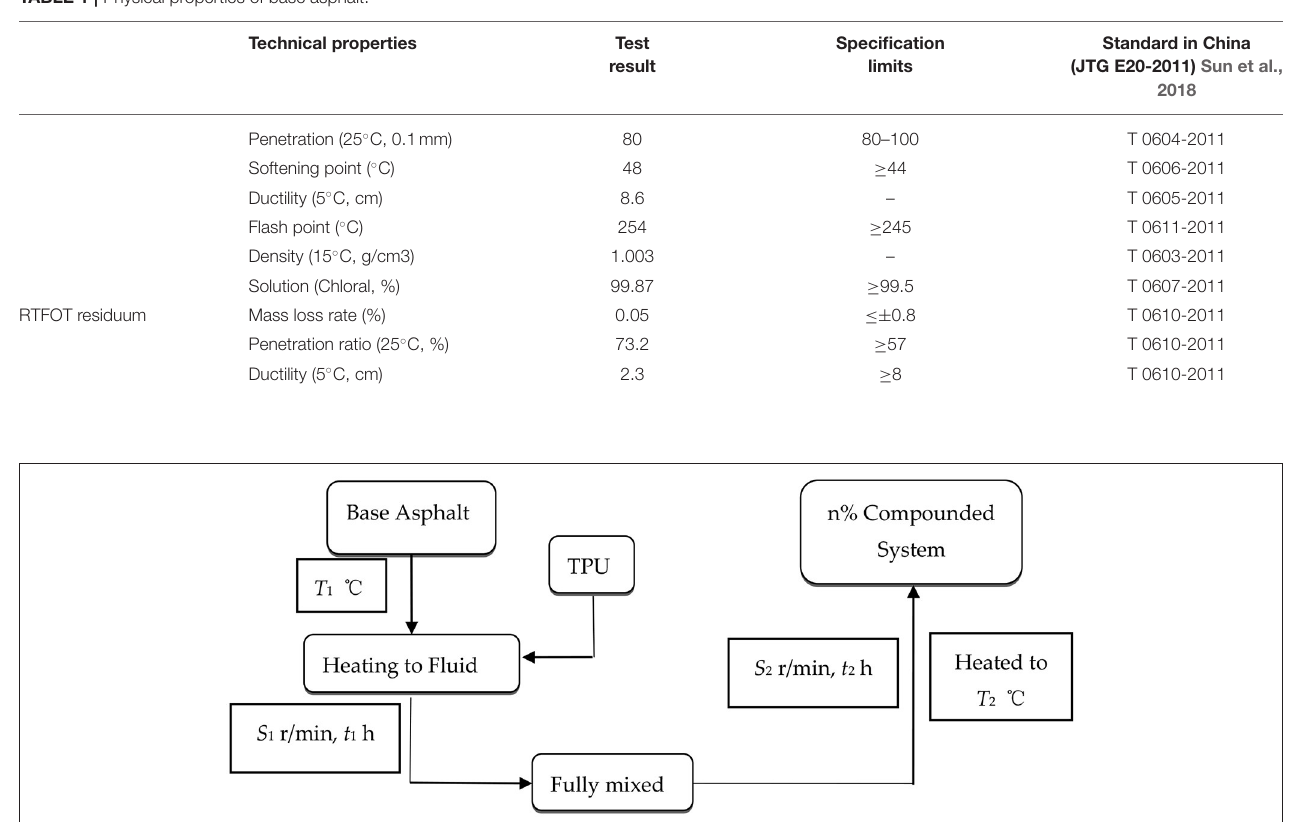
TABLE 1 | Physical properties of base asphalt.